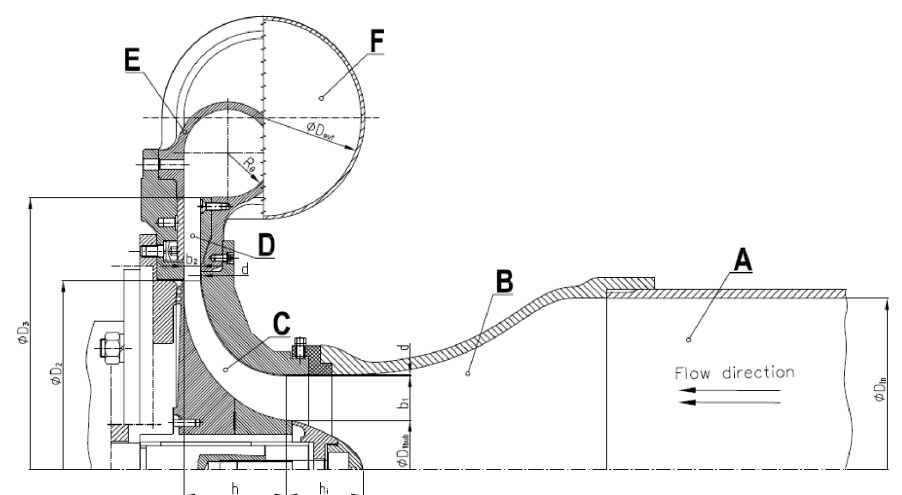
Figure 2. Cross-section of the blower used in the study. (A)—inlet pipe, (B)—Witoszynski nozzle, (C)—impeller, (D)—vane-less diffuser, (E)—circular volute, (F)—outlet pipe. Dimensions presented